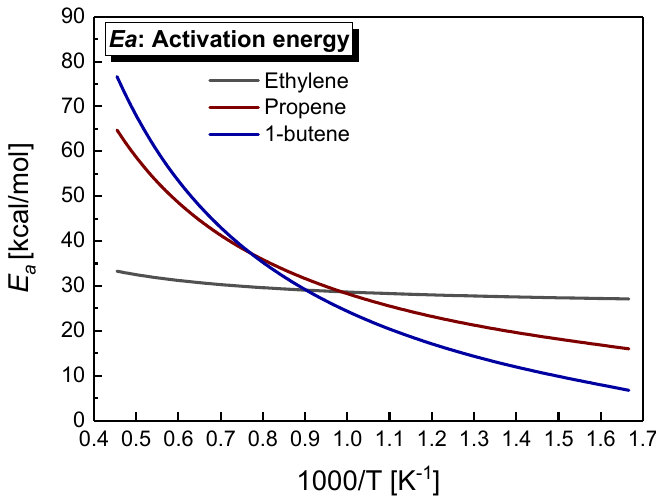
Figure 17. Comparison of global activation energy for ethylene, propene and 1-butene predicted by E a deduced from Equation (2).